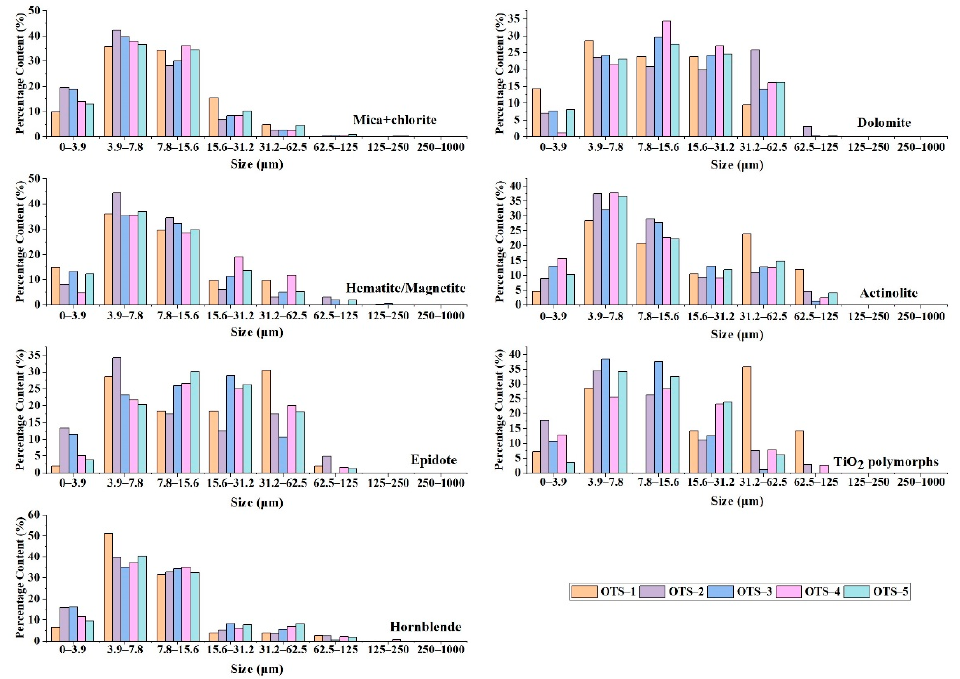
Figure 3. Histogram of grain size distribution of main heavy mineral phases from H4-S2.